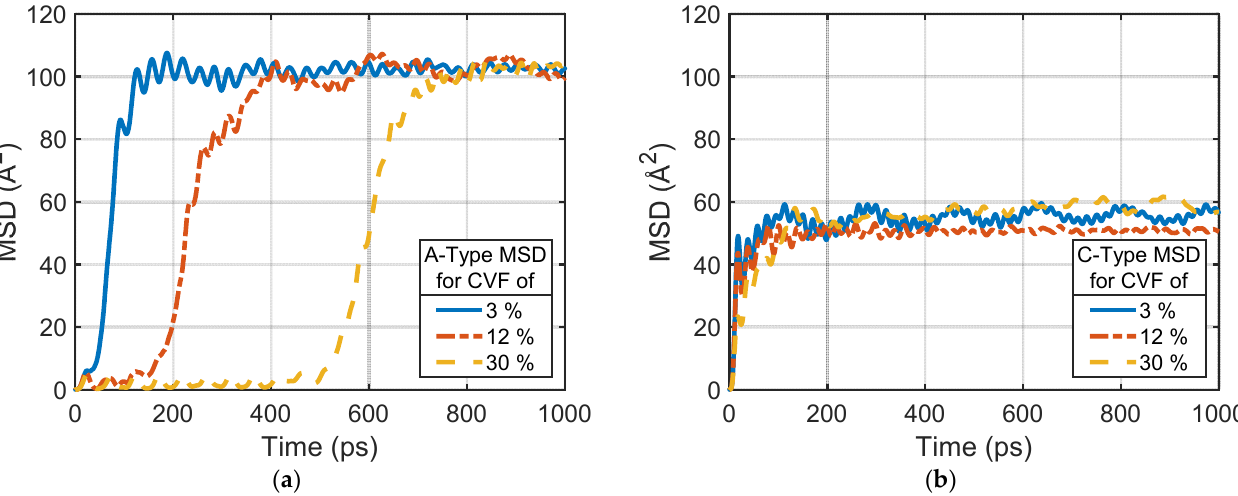
Figure 3. MSD vs. time history for the solid-state sintering of stacked-NPs model with different core volume fractions (CVF) for ( a ) the A-type and ( b ) the C-type stacking patterns.